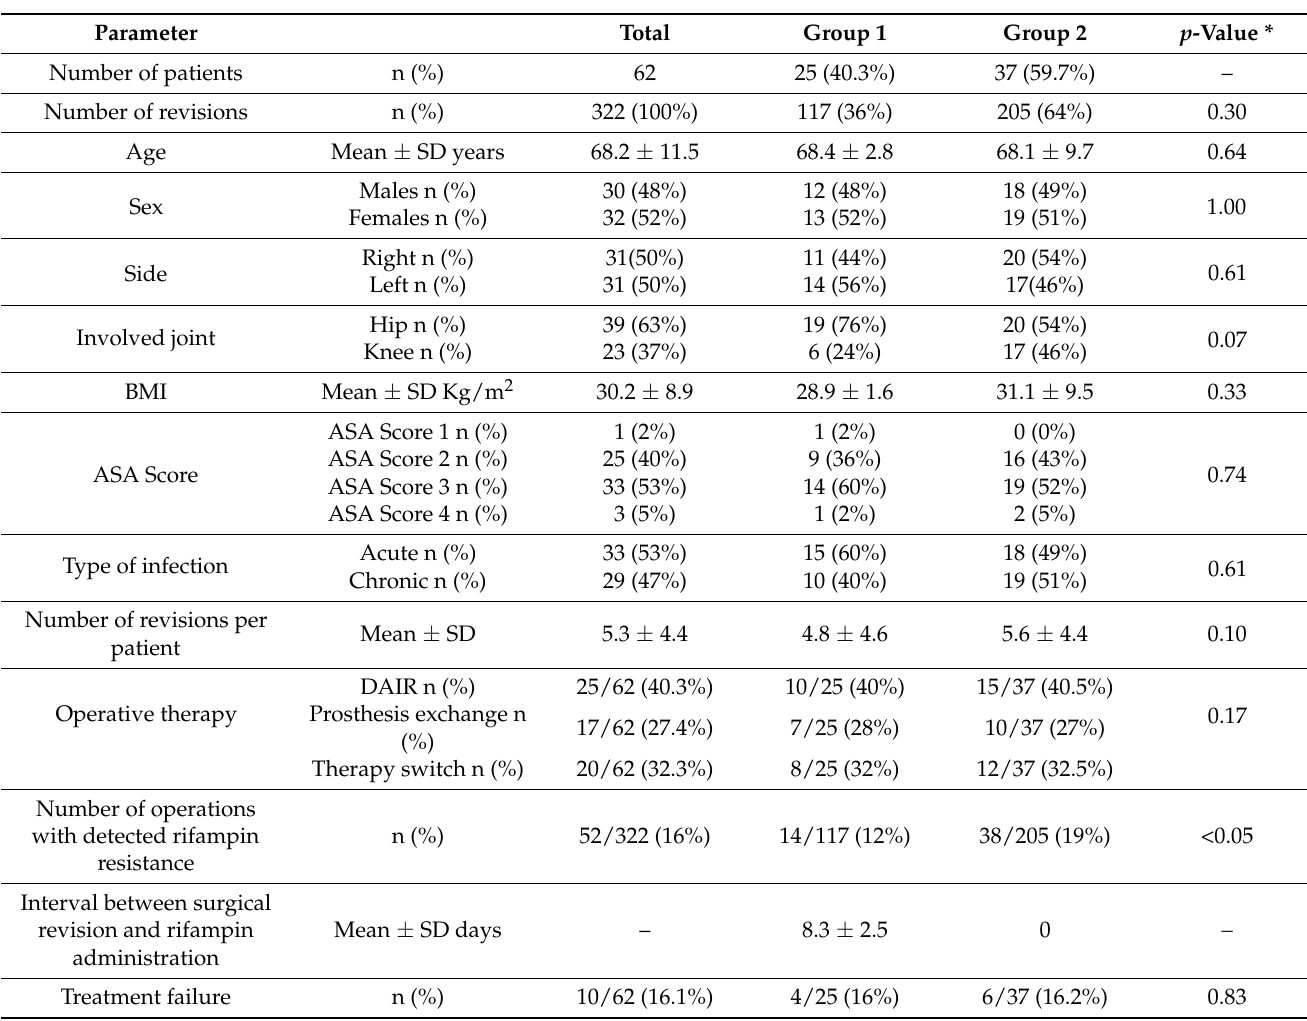
Table 1. Patient